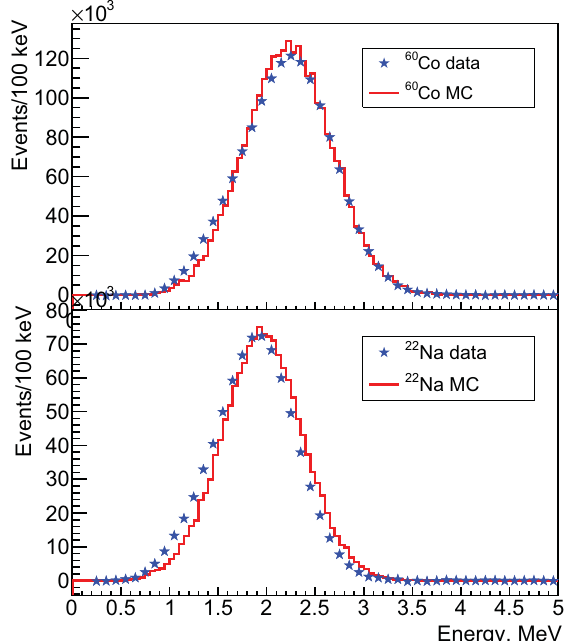
Figure 3. Detector response to the 60 Co and 22 Na sources. Histograms are the MC